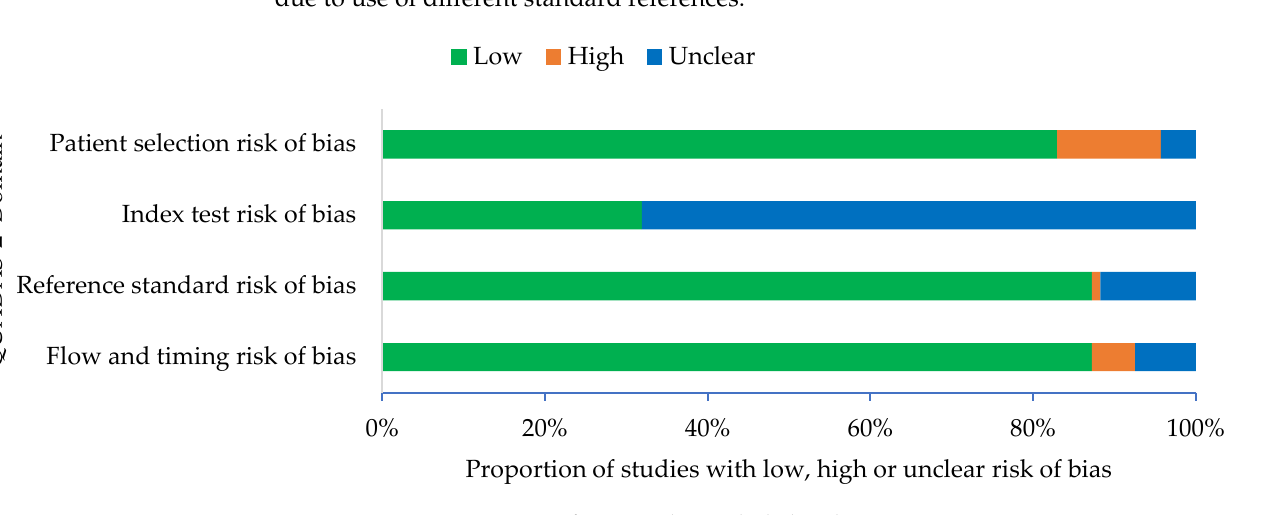
Figure 2. QUADAS-2 criteria for 94 studies included in this systematic review.